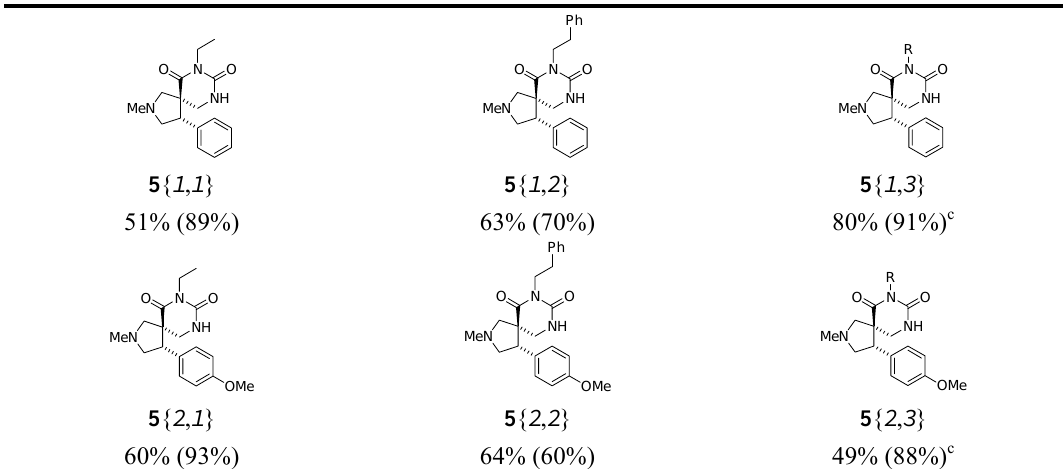
Table 4. Parallel synthesis of spiro dihydrouracil library 5 { 1 – 6 , 1 – 3 } a,b